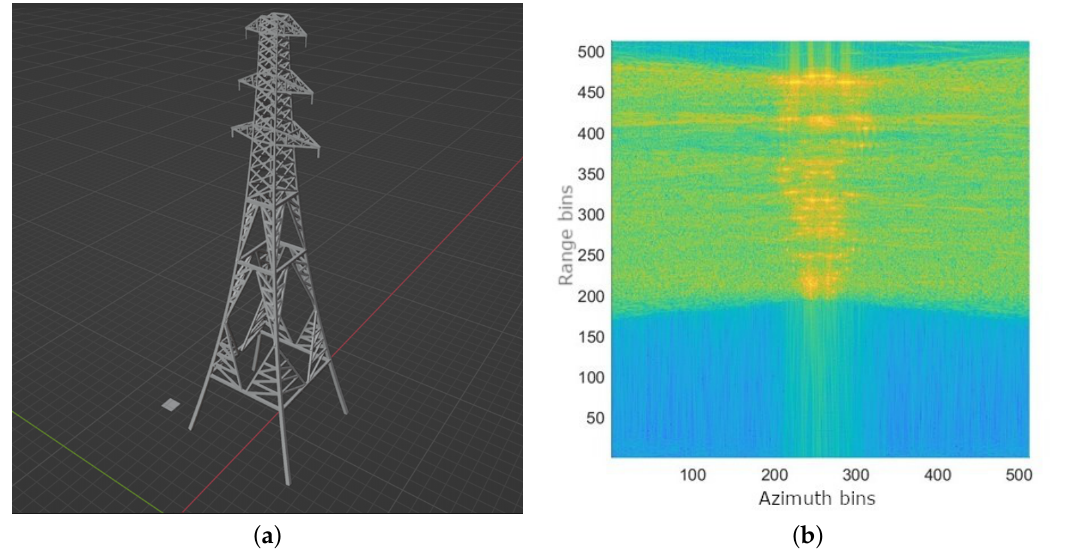
Figure 8. SARCASTIC simulation of electricity pylon. ( a ) CAD model; ( b ) SAR